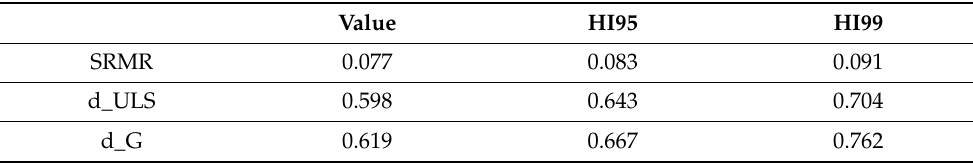
Table 1. Overall model